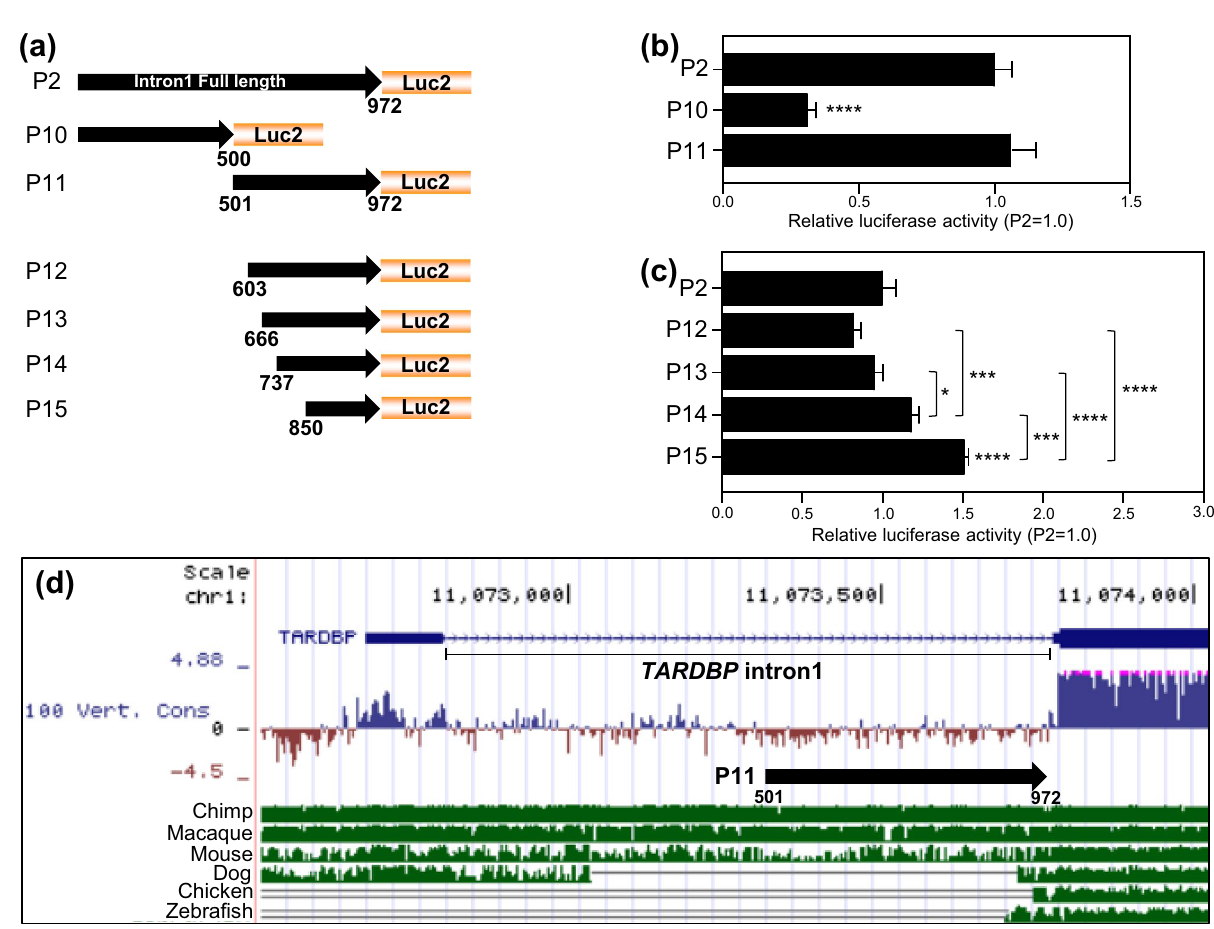
Figure 3. TARDBP intron 1 shows weak promoter activity. ( a ) Schematic images of human TARDBP intron 1/luciferase reporter (P2, 10–15) constructs. Each fragment name is described below: P2 (1/972, full length of intron 1), P10 (1/500), P11 (501/972), P12 (603/972), P13 (666/972), P14 (737/972), and P15 (850/972). ( b , c ) Luciferase assay of TARDBP introns 1/luciferase reporter constructs. n = 5 ( b ) and n = 7 ( c ) replicates; one-way ANOVA with post hoc Dunnett’s test relative to P2 ( b ) or Tukey’s test ( c ). All error bars indicate the means ± SEMs. * P < 0.05, *** P < 0.001, **** P < 0.0001. ( d ) Analysis of TARDBP intron 1 sequence conservation among the chimpanzee, macaque, mouse, dog, chicken and zebrafish genomes using the UCSC genome browser. The thick black arrow indicates the proximal half of intron 1, P11